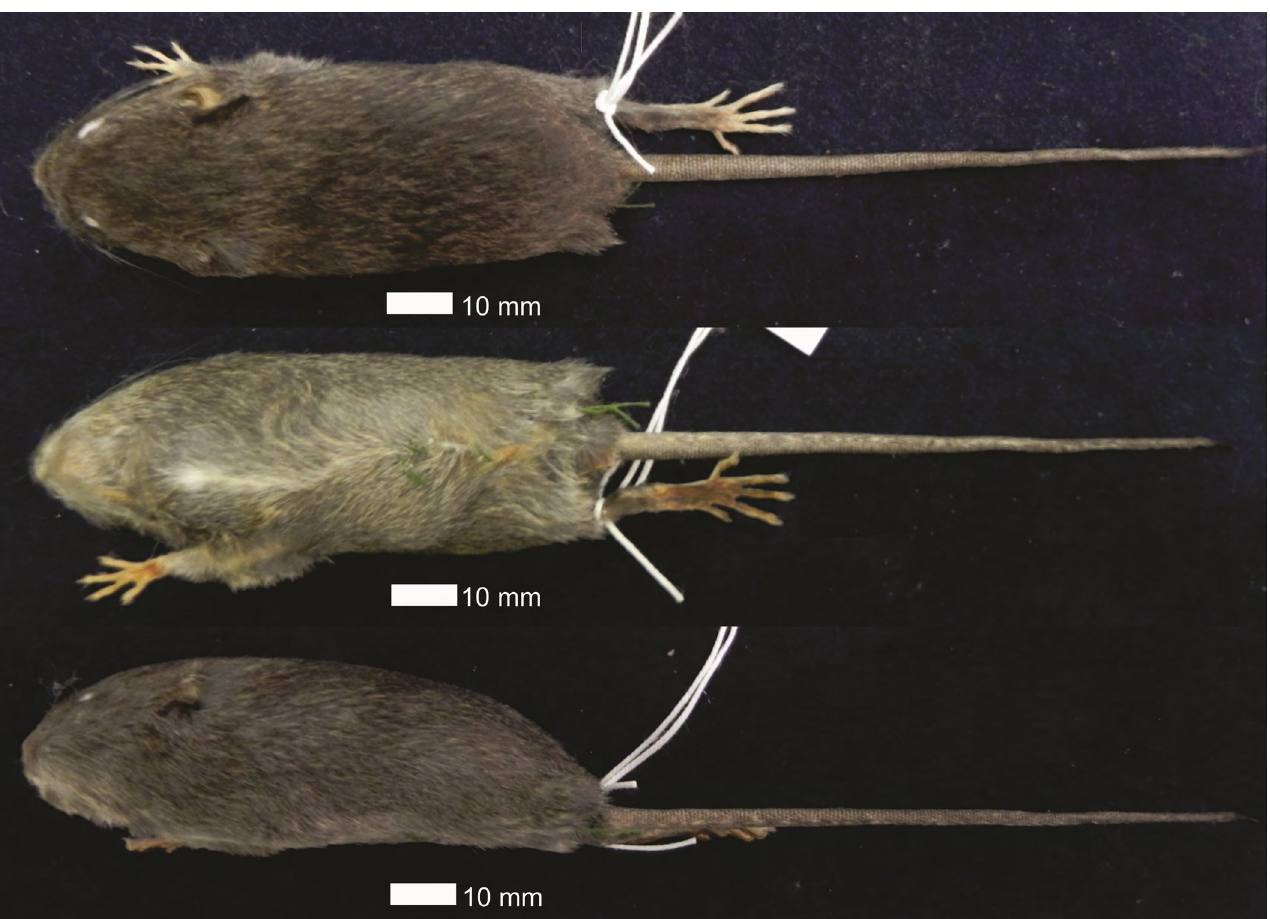
Figure 2. Abrawayaomys ruschii adult female MCNU3629 collected in Chapecó, Santa Catarina state, southern Brazil. Dorsal, ventral, and lateral views of the skin. The scale bar (white) in each photo represents 10